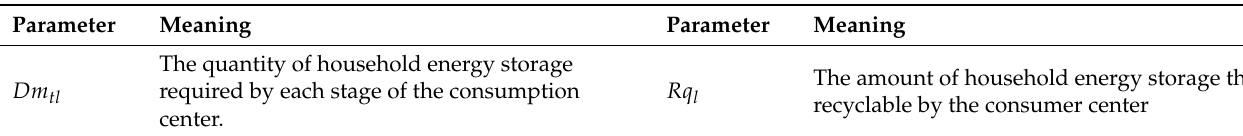
Table 5. Relevant parameters of the consumption center.